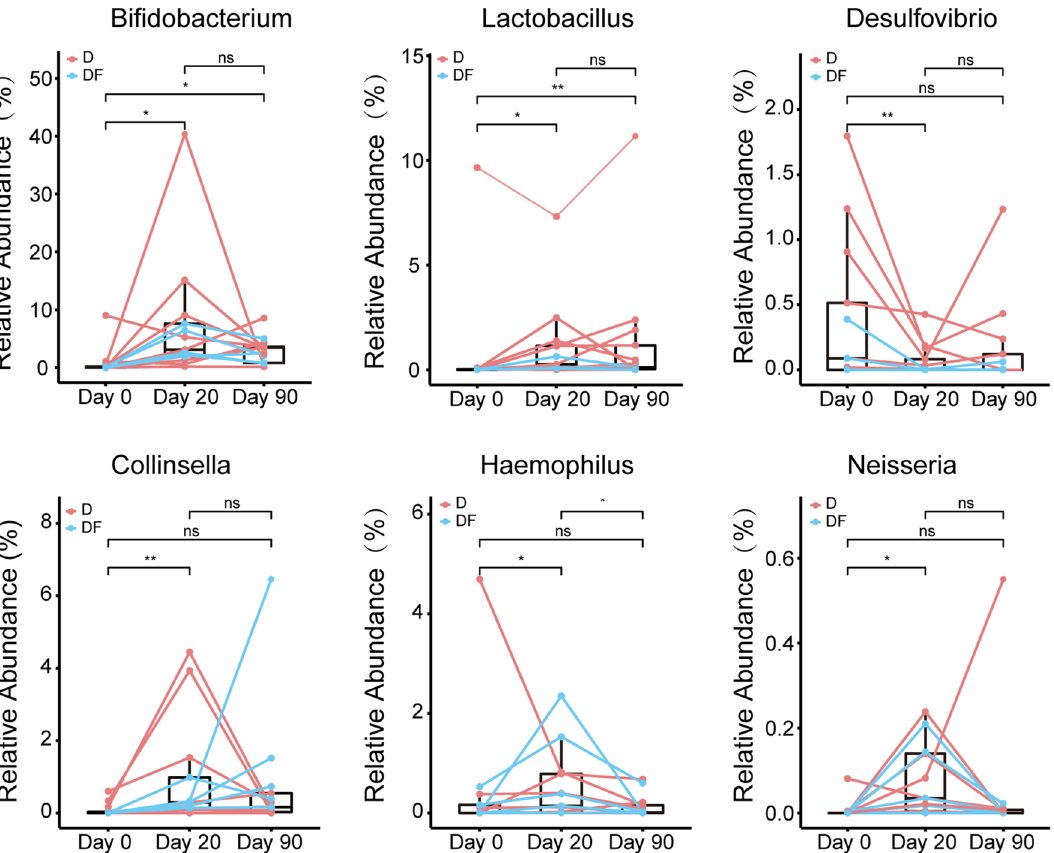
Figure 6. Metagenomic biomarkers associated with diet and diet plus FMT intervention. The relative abundance of selected genus were plotted for each subgroup. *p < 0.05; **p < 0.01. Two tailed Wilcox matched- pair signed-rank test was used for the statistical